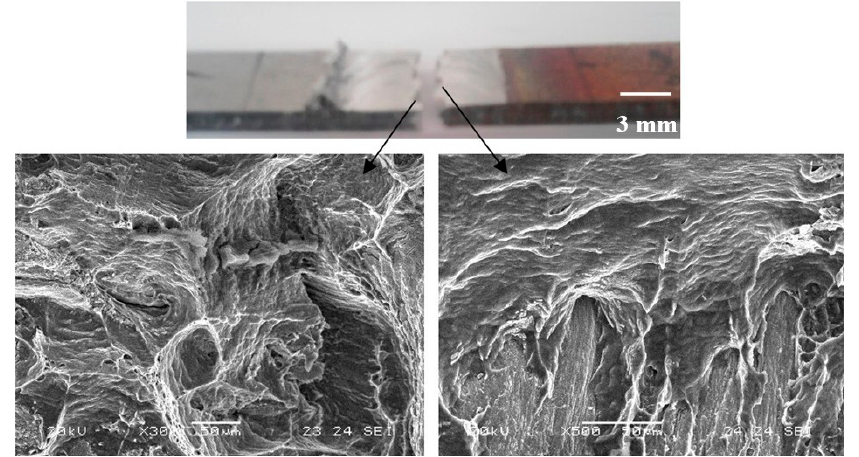
Figure 9. Surface images after tensile tests and scanning electron microscope (SEM) images of ruptured surface of welded joints in the 1330/20/1 specimen.